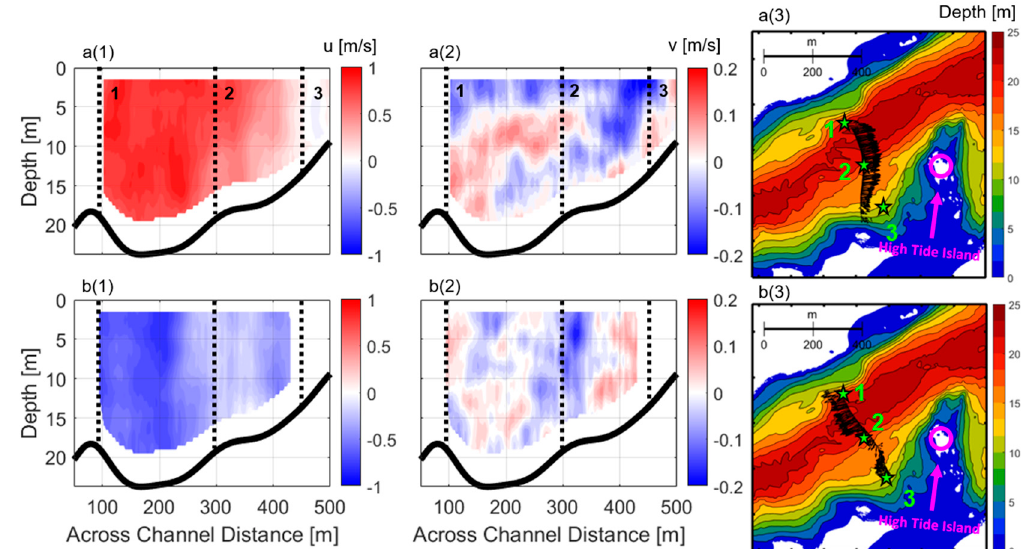
Figure 3. During maximum flood ( a panels) and ebb ( b panels) tides: Streamwise (column 1) and stream-normal (column 2) velocities with respect to cross-channel distance ( x axis) and depth ( y axis). Positive u is landward, and positive v is to the right. The black dotted lines represent the approximate locations of each MicroCTD sampling station on the transect line. Current vectors for the top 10 m of the water column are shown on a bathymetric map for each tide (column 3). Each station is noted with a green star and High Tide Island is circled in magenta.